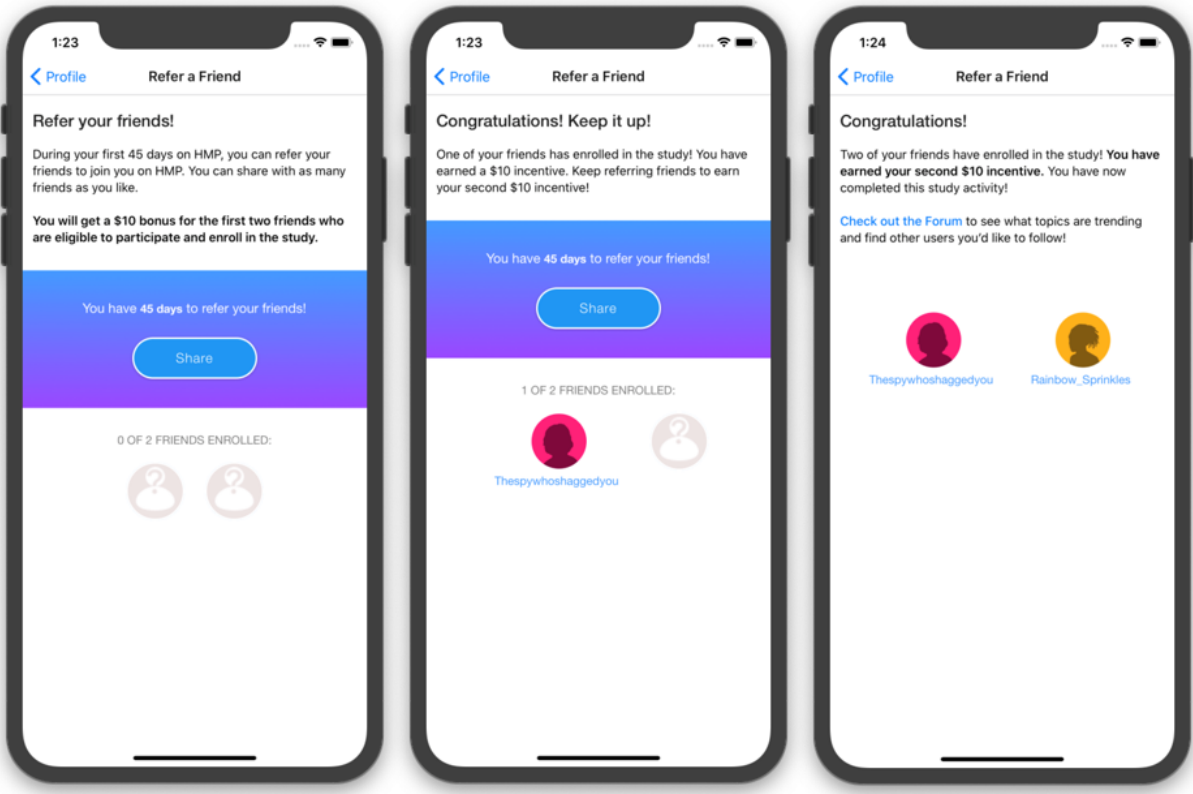
Figure 10. Example screenshots of peer referral feature from HealthMpowerment (HMP) 2.0 intervention arm